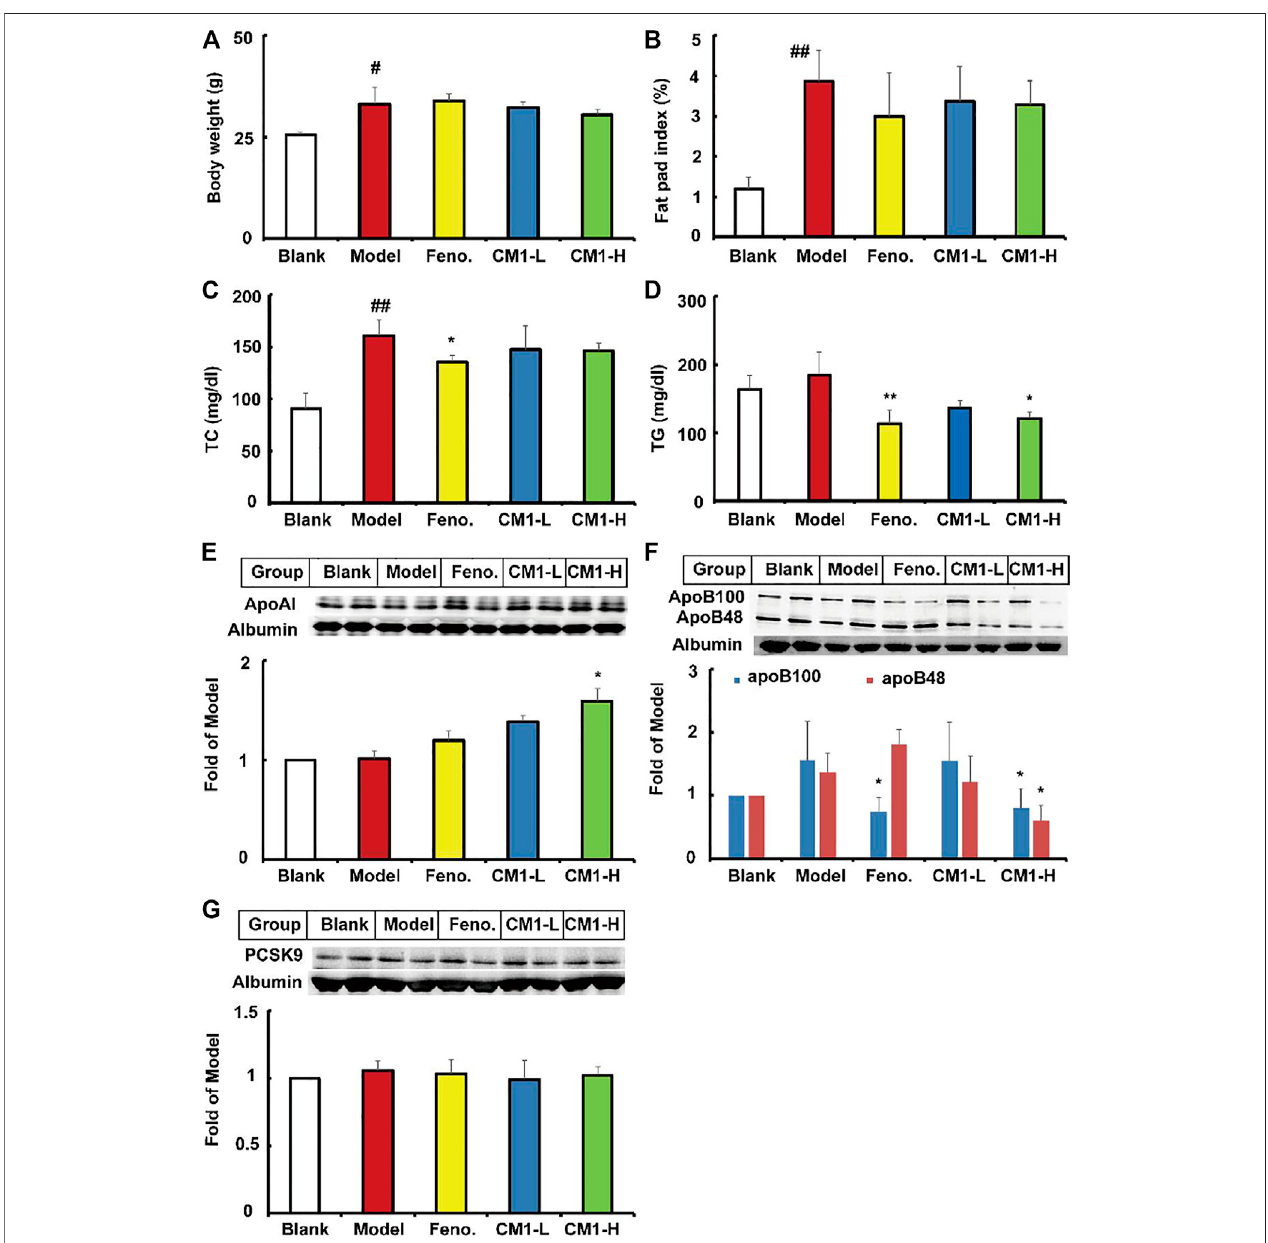
FIGURE 8 | Effect of CM1 on the lipid pro fi le and protein levels in the plasma of the C57BL/6J mice ( n ≥ 4). (A) , body weight of the mice; (B) , fat pad index of the mice; (C) , plasma TC concentrations; (D) , plasma TG concentrations; (E) , plasma apoAI expression and densitometric quanti fi cation; (F) , plasma apoB expression and densitometric quanti fi cation; (G) , plasma PCSK9 expression and densitometric quanti fi cation. # means p < 0.05 vs . Blank; ## means p < 0.01 vs . Blank; *means p < 0.05 vs . Model, and **means p < 0.01 vs . Model.